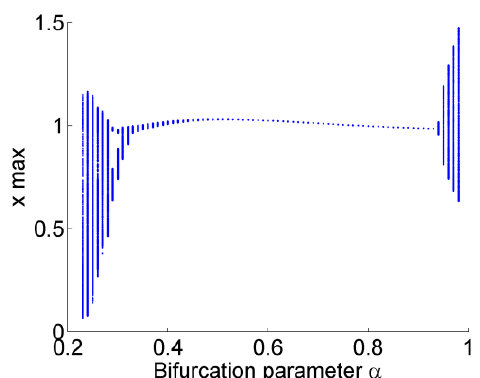
Figure 3. Hidden quasi-periodic attractor of system (4) when α = 0.95. ( a ) Phase trajectory diagram in yz plane; ( b ) Poincare map in xz plane.